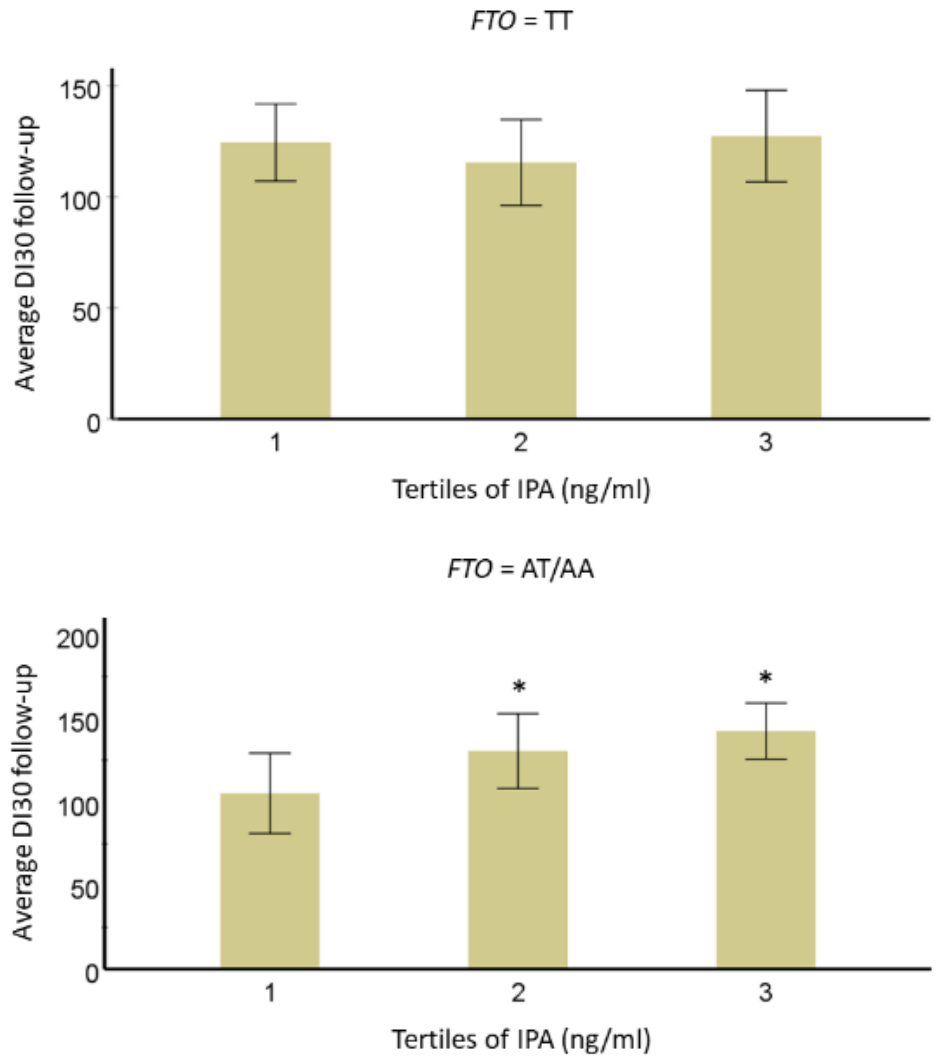
Figure 4. Averaged disposition index during the 7-year follow-up by third for serum IPA concentration (models adjusted for age, sex, BMI, and study group) divided based on the presence of major or minor allele of FTO in the DPS. * Represents p -value < 0.05 vs. 3rd one for IPA. The bars represent the estimated marginal means with confidence intervals (95%).